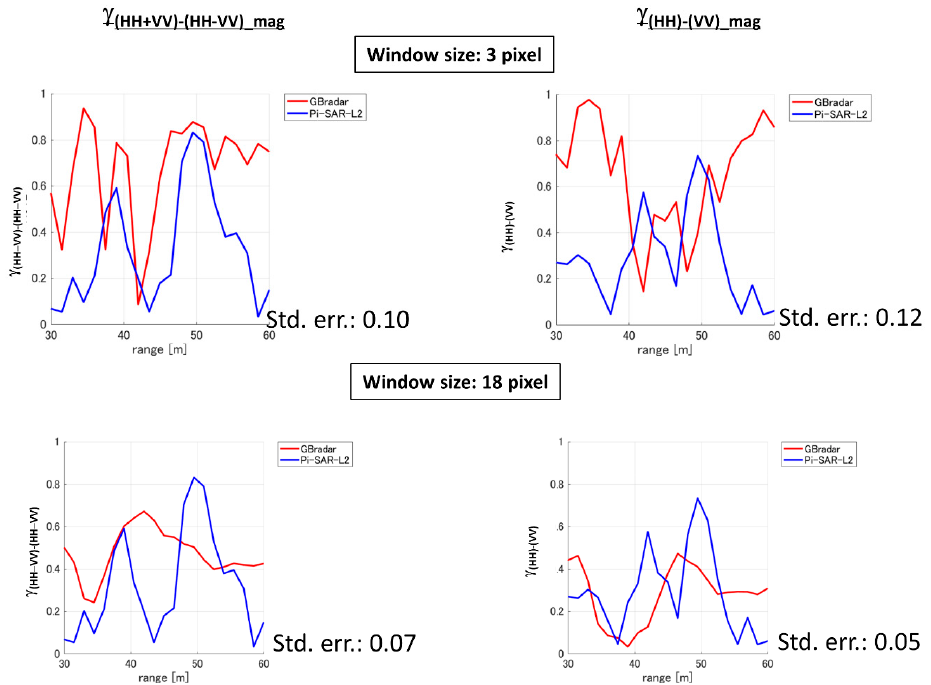
Figure 10. Range profiles of various polarimetric coherence parameters obtained for GB-radar ( red ) and Pi-SAR-L2 ( blue ).